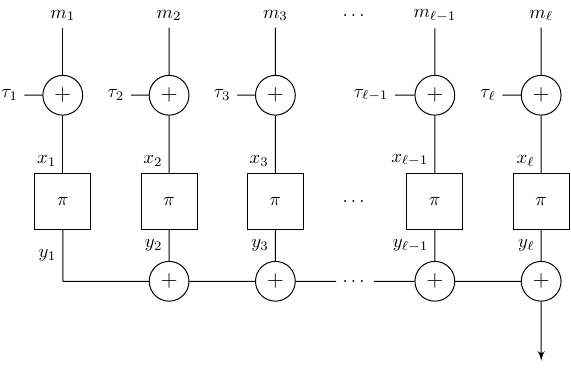
Figure 1: The evaluation of sPMAC ( π, τ, m 1 k . . . k m ‘ ), where τ i = τ ( i